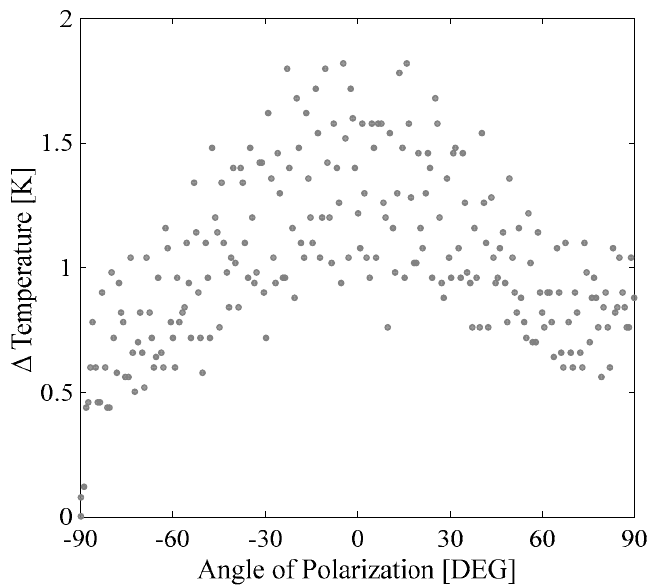
Figure 5. Change in temperature ( Δ T) vs. angle of polarization of the incident beams in a two − wave mixing experiment in the SiNPs+N sample irradiated by nanosecond pulses at 532 nm.